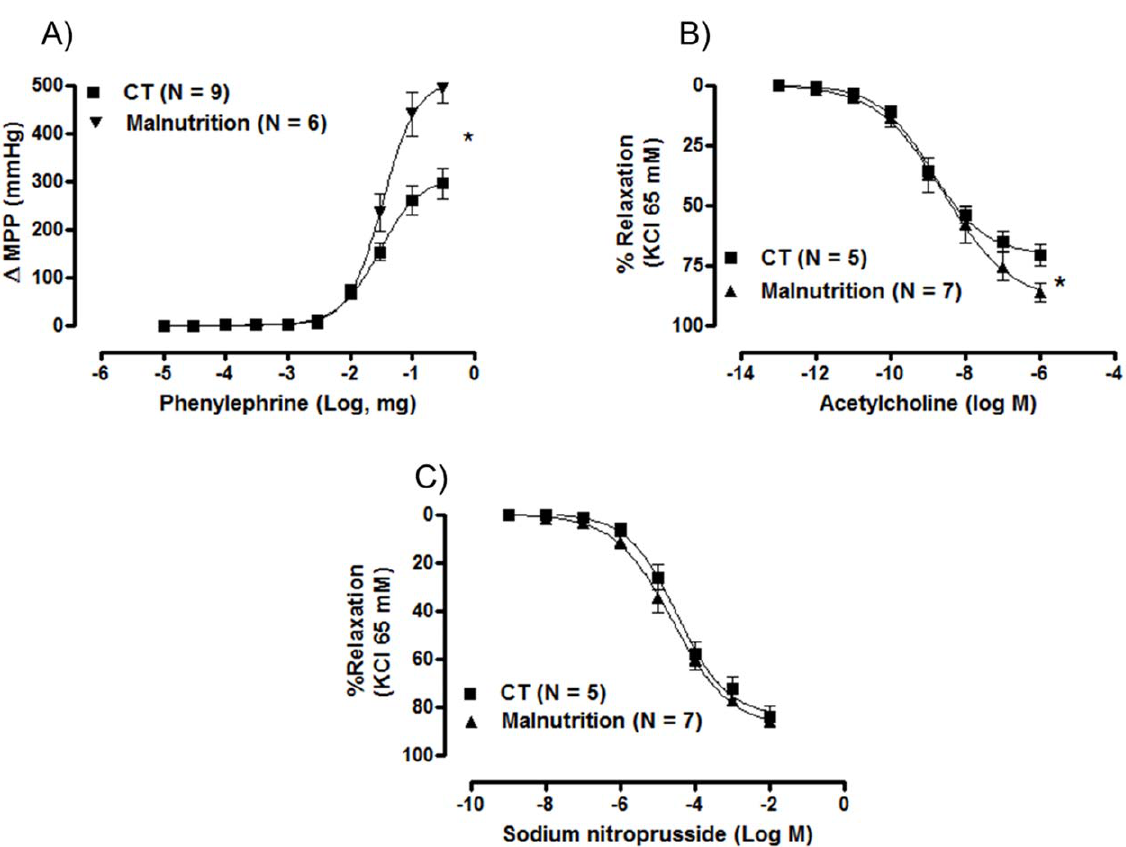
Figure 5. (A) Changes in the mean perfusion pressure (MPP) produced by phenylephrine (PHE) in tail vascular beds from the control (CT) and post-weaning protein malnutrition groups (Malnutrition). (B) Concentration-response curves produced by acetylcholine (ACh) in the tail vascular beds previously contracted with potassium chloride (KCl, 65 mM) (C) Concentration-response curves produced by sodium nitroprusside (SNP) in the tail artery bed previously contracted with with potassium chloride (KCl, 65 mM). The number of preparations is indicated in parenthesis. The results are expressed as the means 6 SEM. * P , 0.05 for Rmax: CT vs. Malnutrition, Student’s t- test.